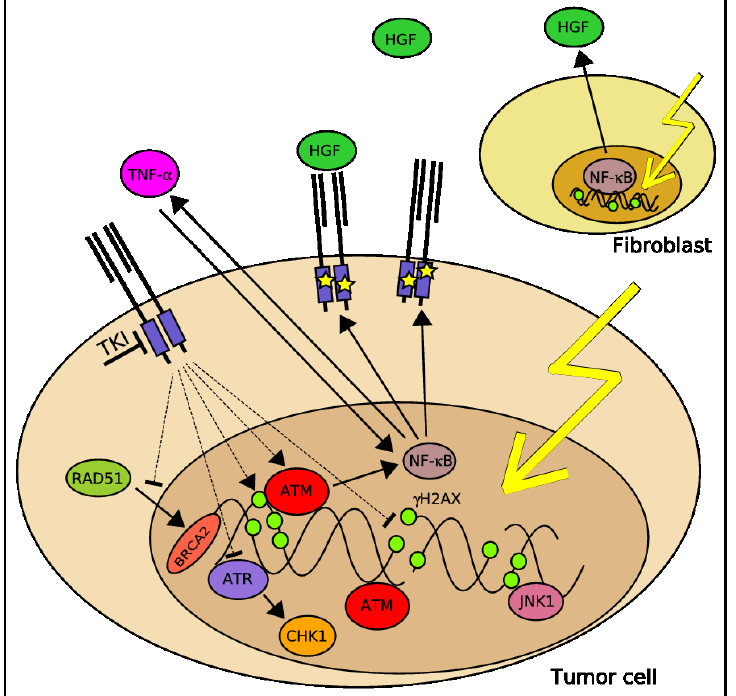
Figure 2. DDR sensors, mediators and effectors that have been shown to be modulated by MET signaling and/or MET inhibition alone or in combination with DDAs ( full lines— direct links, broken lines— links that have not been proven